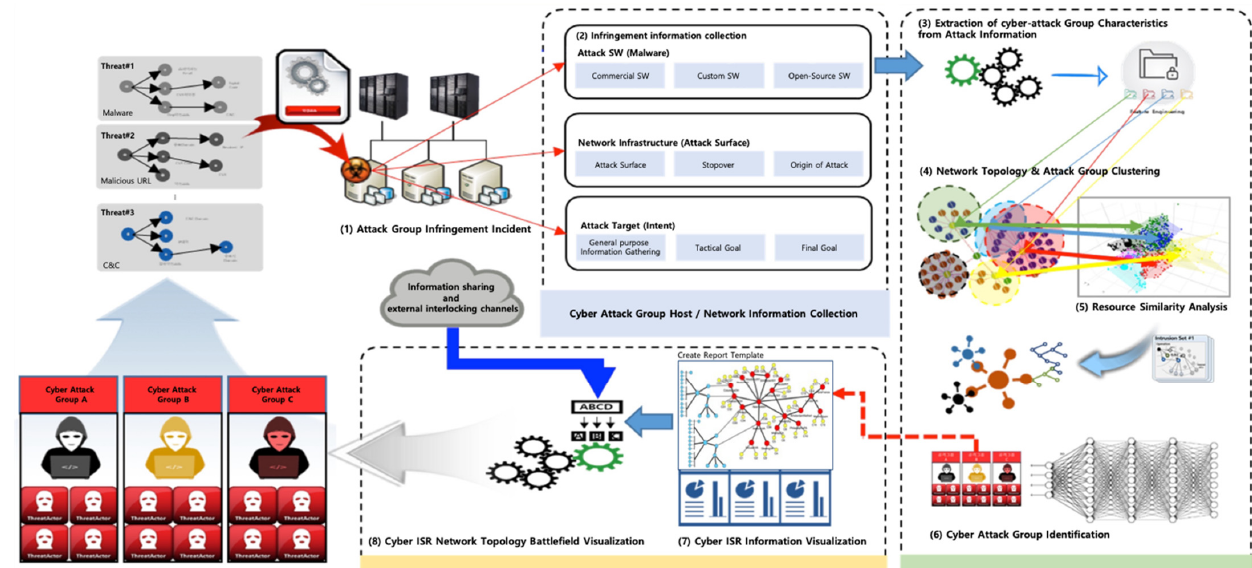
Figure 7. Design of cyber ISR visualization framework architecture.